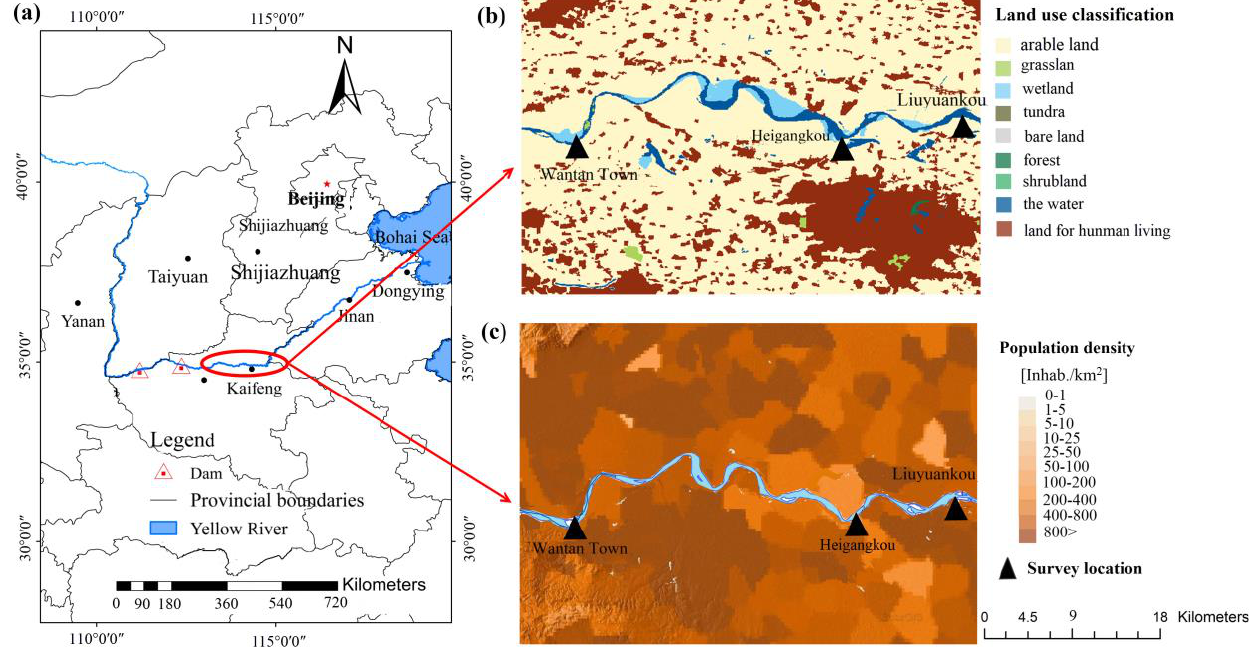
Figure 1. The location of the study area: ( a ) specific locations of the study area; ( b ) land use classification of the study area; ( c ) population density of study area.